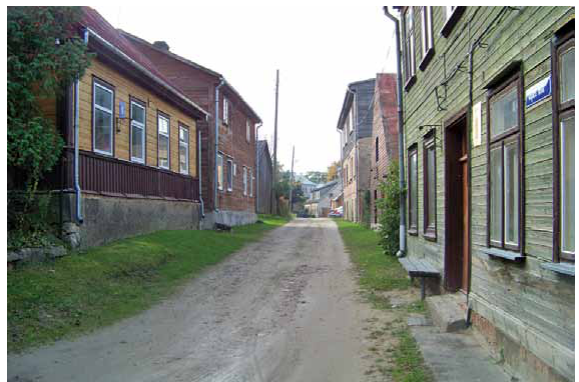
Fig. 9. The historical buildings in upes street. Source: author’s photo,